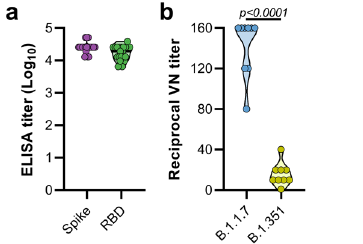
Fig. 1 Vaccination of Syrian hamsters with ChAdOx1 nCoV-19 elicits binding and neutralizing antibodies against B.1.1.7 and B.1.351. a Violin plot of binding antibodies against spike protein or RBD of SARS-CoV-2 (clade A) in serum obtained 25 days post vaccination with ChAdOx1 nCoV- 19. b Violin plot of virus neutralizing antibody titers against B.1.1.7 or B.1.351 in serum obtained 25 days post vaccination with ChAdOx1